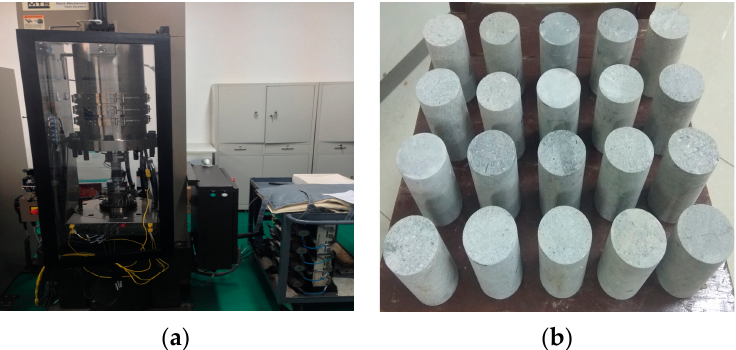
Figure 1. Test equipment and rock specimens. ( a ) MTS815.02 triaxial test system; ( b ) sandstone.